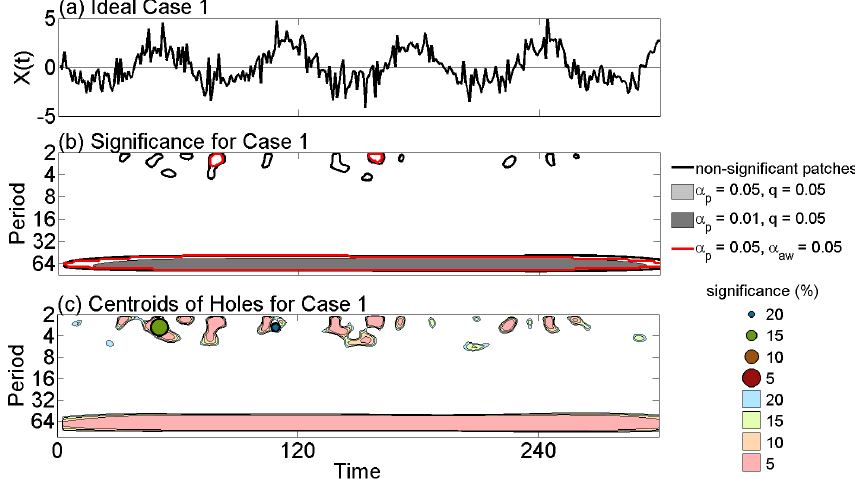
Figure 8. (a) Time series of Case 1, which results from passing a single sinusoidal input with period λ = 64 through Eq. (16). Gaussian additive white noise with a signal-to-noise of 2 was added to the output response. (b) The significance of wavelet power for Case 1 (see Fig. 3 for details). (c) Topological wavelet diagram corresponding to (b) . Points are the centroids of the holes at a given pointwise significance level, where both the color and size of the dots indicate the pointwise significance level at which the hole existed. The shading of the patches corresponds to the pointwise significance level at which the wavelet power coefficient existed, with the color of the shading lighter than the dots for